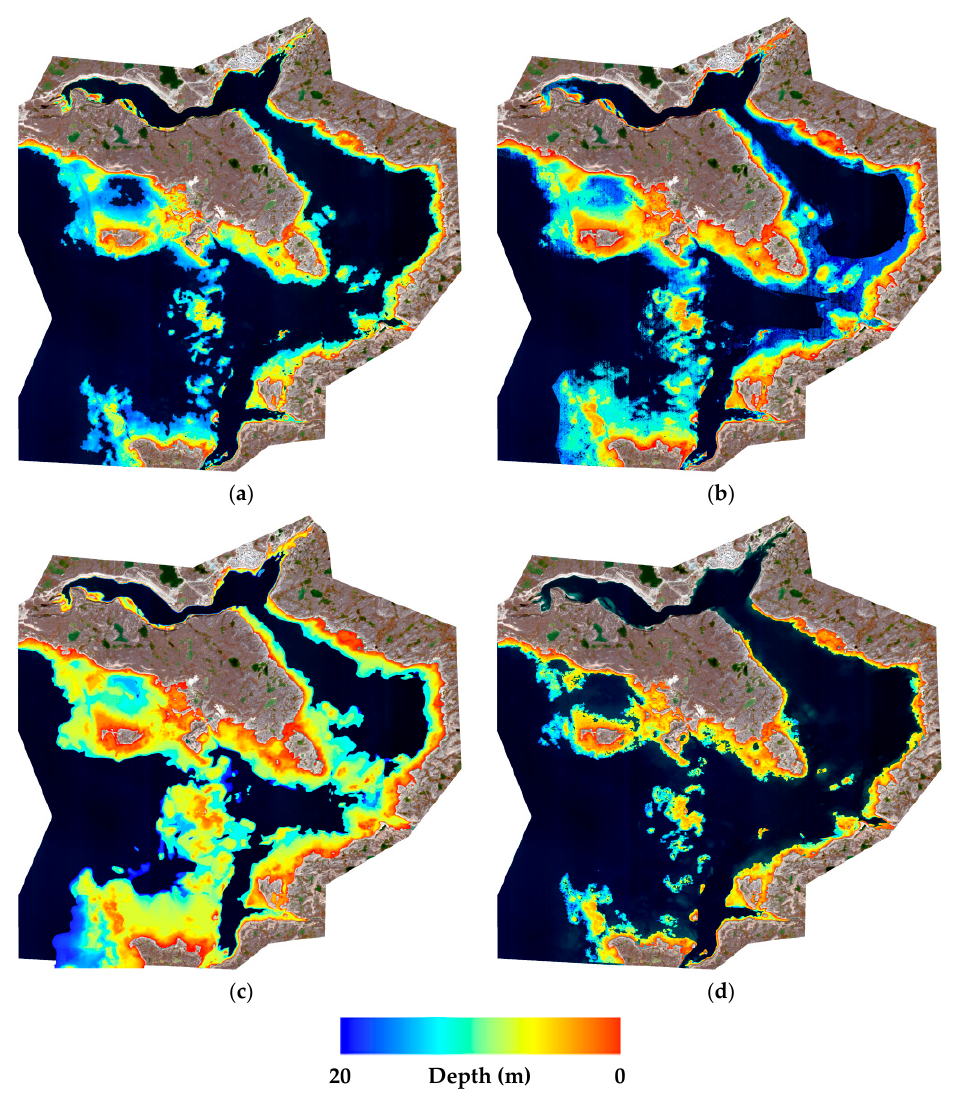
Figure 4. SDB results from the ( a ) manual photogrammetry, ( b ) classification, ( c ) empirical and ( d ) automatic photogrammetry techniques. Imagery © 2015, DigitalGlobe, Inc. Table 3. Accuracy assessment results for individual SDB techniques.